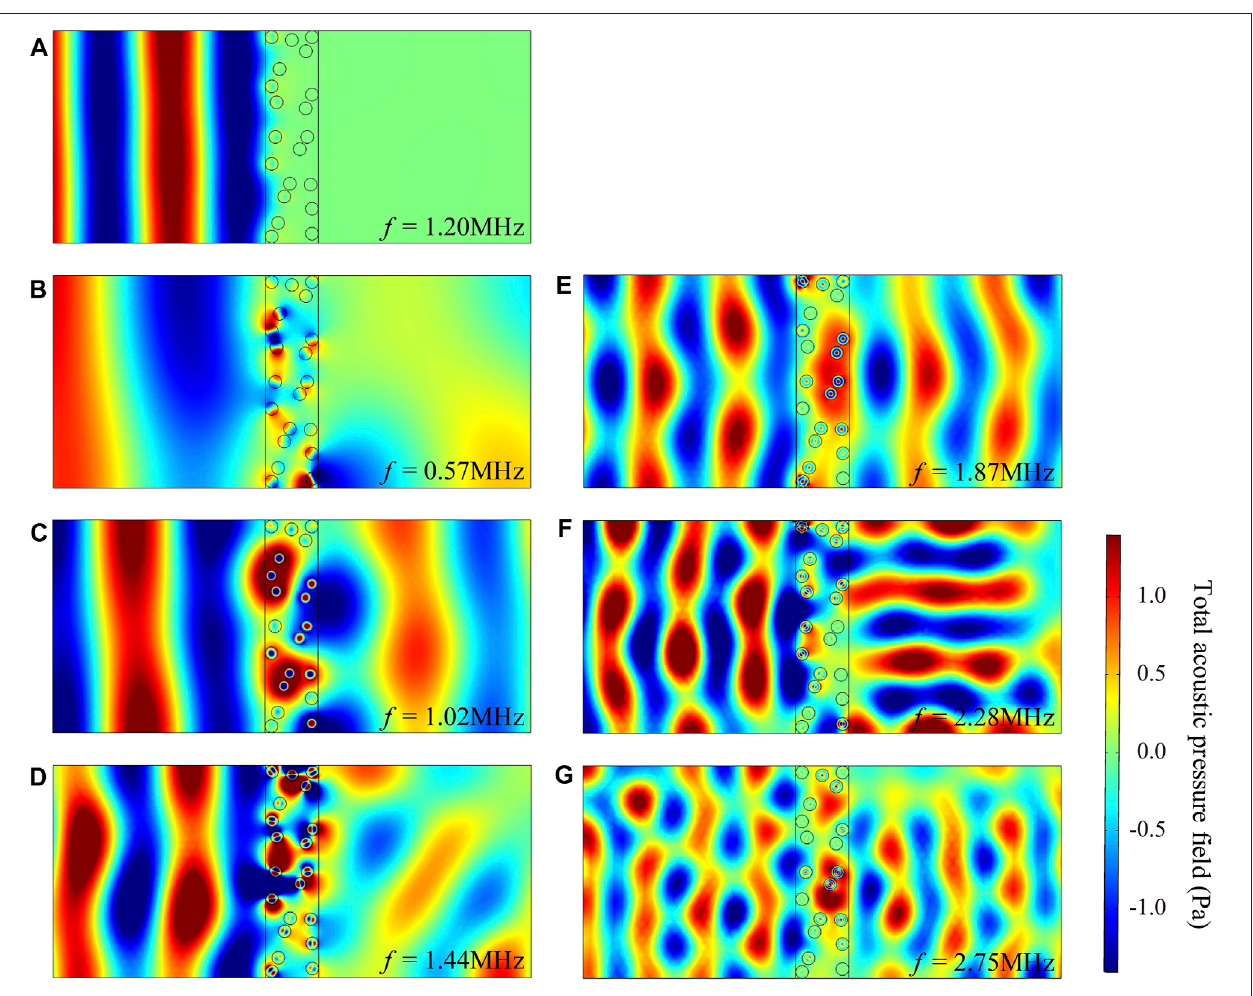
FIGURE 3 | Total acoustic pressure fi eld at seven different frequencies corresponding to rubber scatterers in water. (A) Total acoustic pressure fi eld at non- resonant frequency 1.20 MHz. (B) – (G) Total acoustic pressure fi eld at six different resonant frequencies: 0.57, 1.02, 1.44, 1.87, 2.28, and 2.75 MHz, respectively.